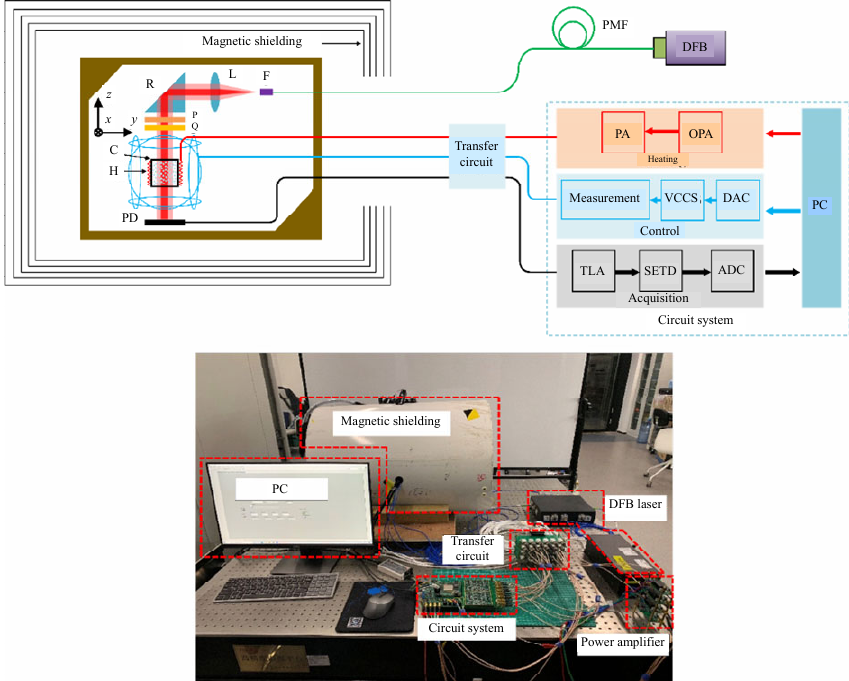
Fig. 3 Experimental diagram and actual photographs: (a) measurement experimental block diagram (the AM is in the magnetic shielding. H: heat coils; C: rubidium vapor cell; Q: quarter wave plate; P: linear polarizer; R: reflecting prism; L: collimating lens; F: fiber port; PA: power amplifier; OPA: operational amplifier; VCCS: voltage-controlled current source; TIA: trans-impedance amplifier; SETD: single-ended to differential, a circuit structure for use with a fully differential high-precision ADC) and (b) sensor performance testing